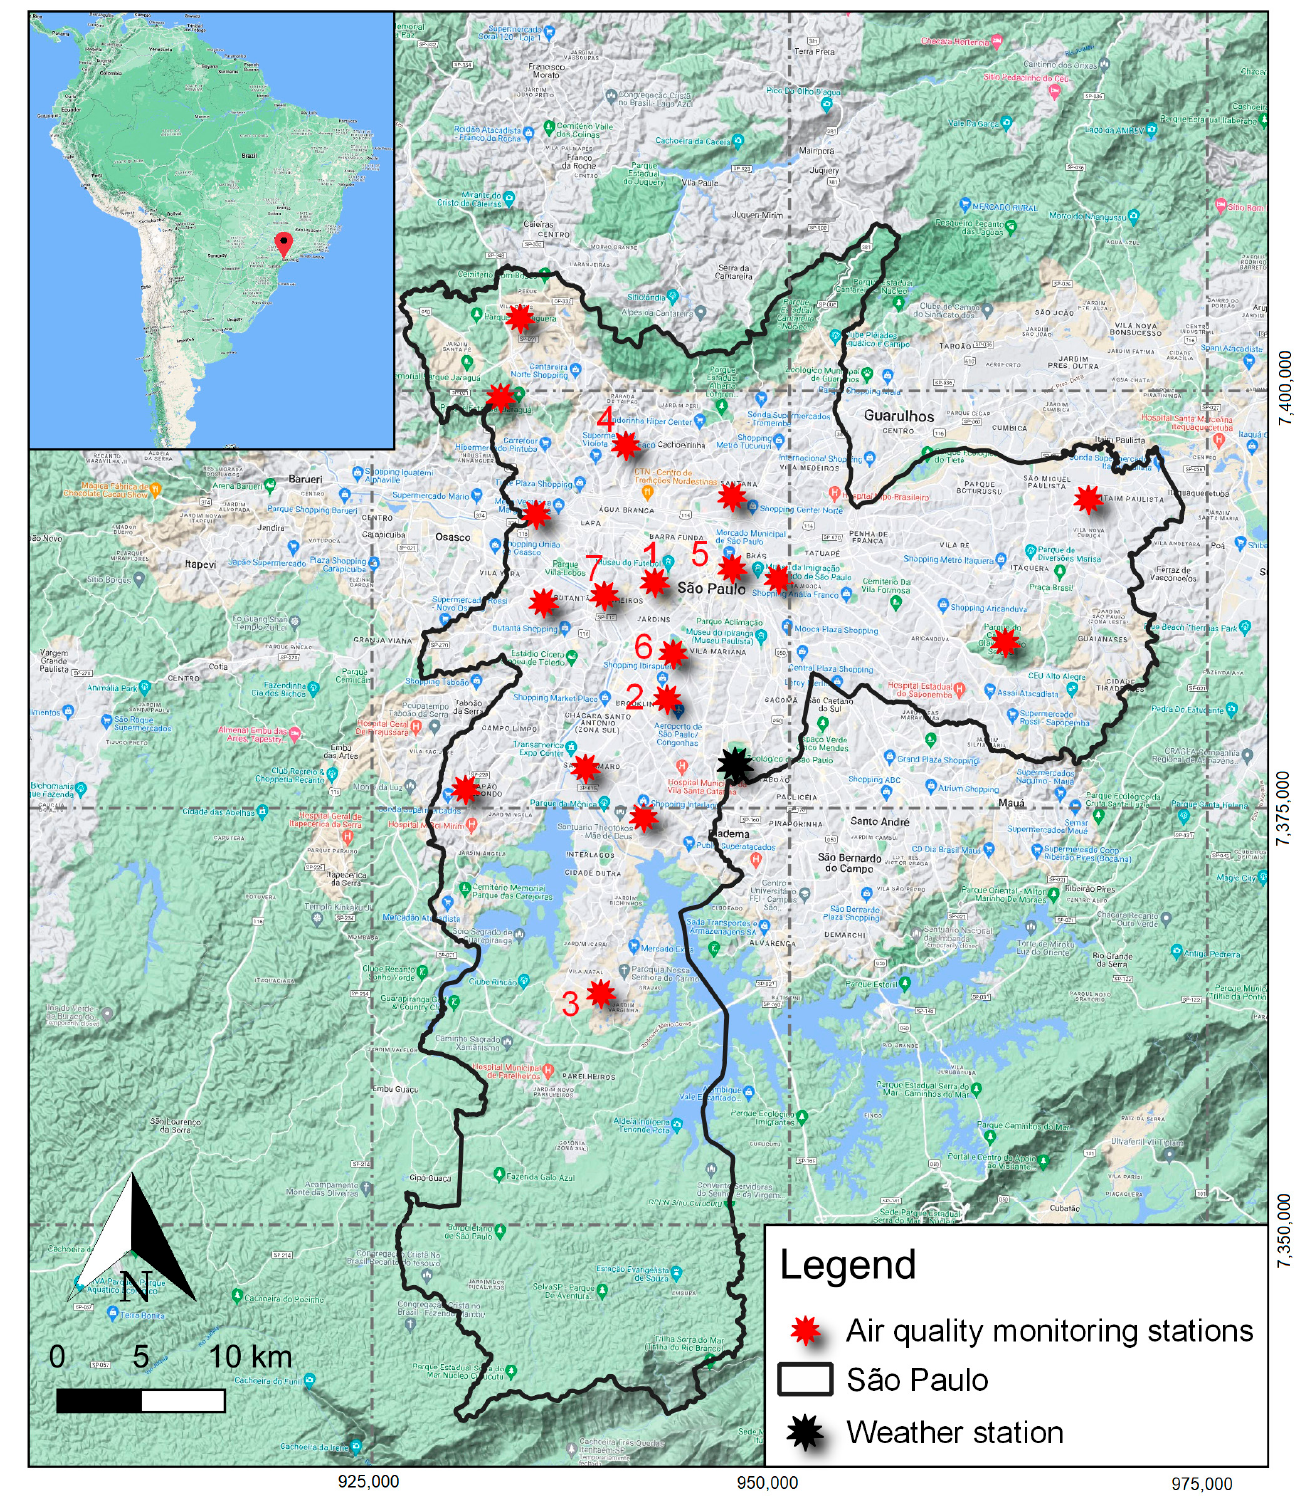
Figure 1. Map illustrating the Sao Paulo municipality and its 18 air quality monitoring stations. The numbers 1 to 7 indicate the following stations: Cerqueira César, Congonhas, Grajaú, Nossa Senhora do Ó, Parque D. Pedro II, Ibirapuera, and Pinheiros. Source: Elaborated by the authors on QGIS 2.18.20 software.